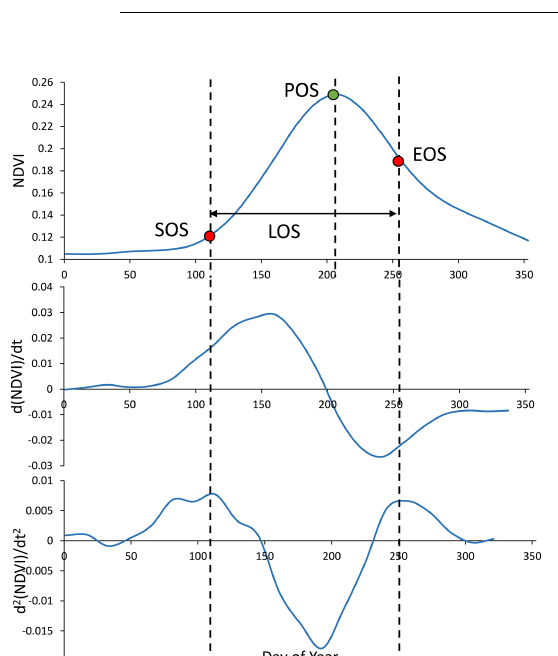
Figure 3. The extraction of phenology dates from NDVI. SOS is the start of growing season; POS is the maximum NDVI date during the growing season; EOS is the date of the end of season; LOS is the length of growing season.